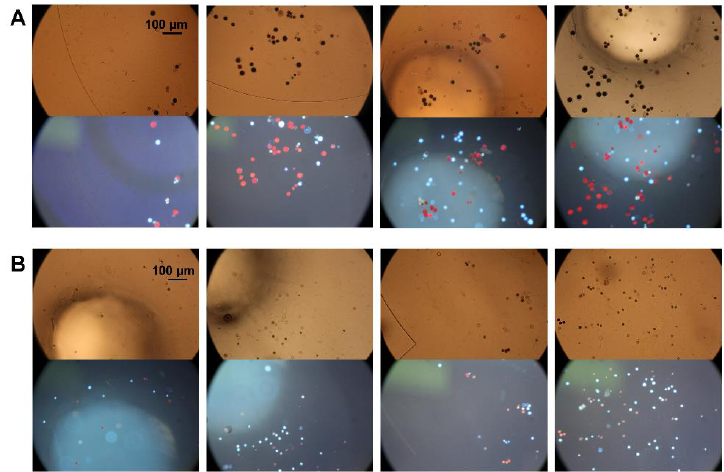
Figure 9. Algae cell collection results: ( A ) algae cells in the first-stage collection area; and ( B ) algae cells in the second-stage collection area.